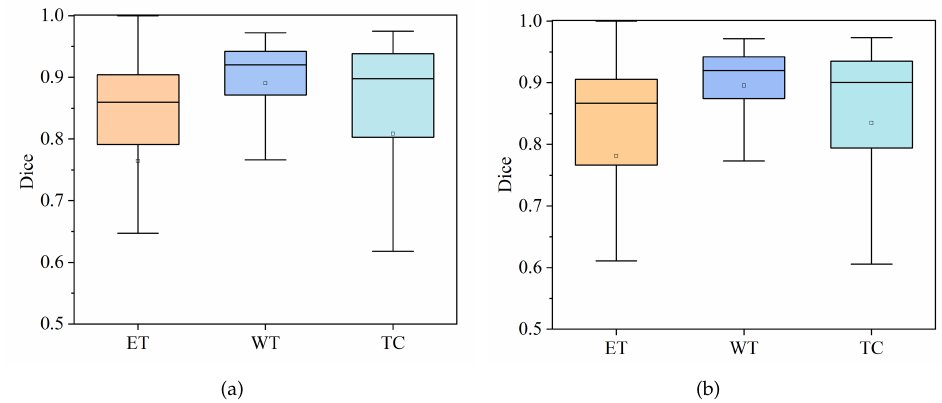
Figure 6. Dice coefficient boxplot on the BraTS2020 validation set. ( a ) stands for HDC-Net, and ( b ) stands for MVKS-Net.